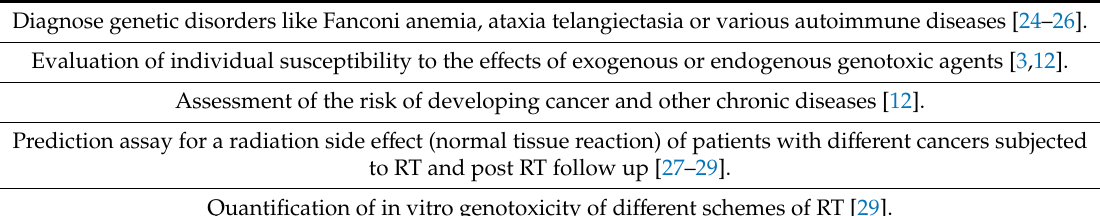
Table 1. Examples of the applications of cytokinesis-block micronucleus assay to detect and study genetic and civilization